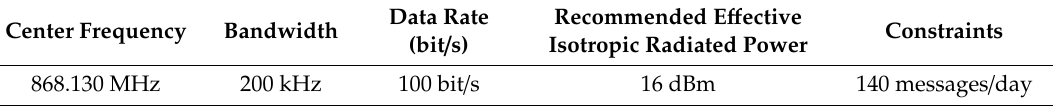
Table 1. Sigfox characteristics for Radio Configuration 1 (the one used in